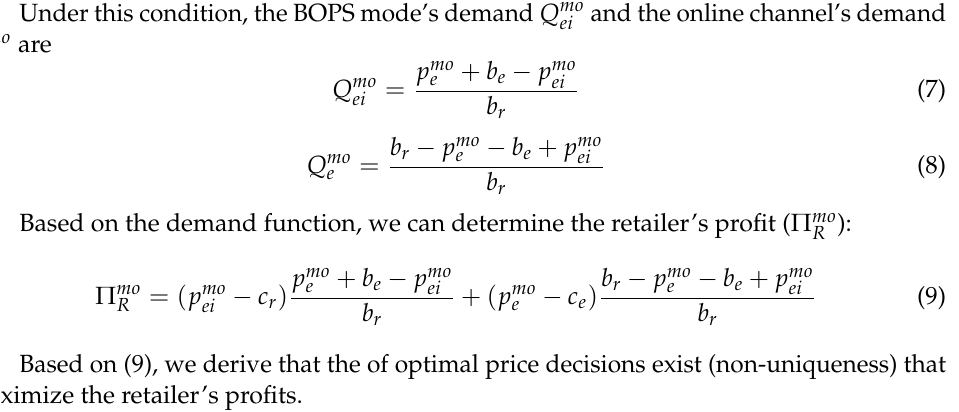
Figure 2. Retailer’s demand under BOPS and monopoly case.